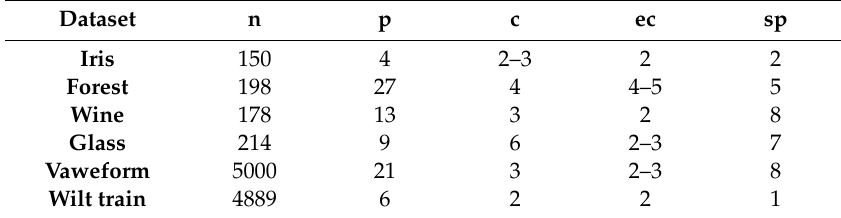
Table 5. The real datasets used to compare the performances of compared algorithms.